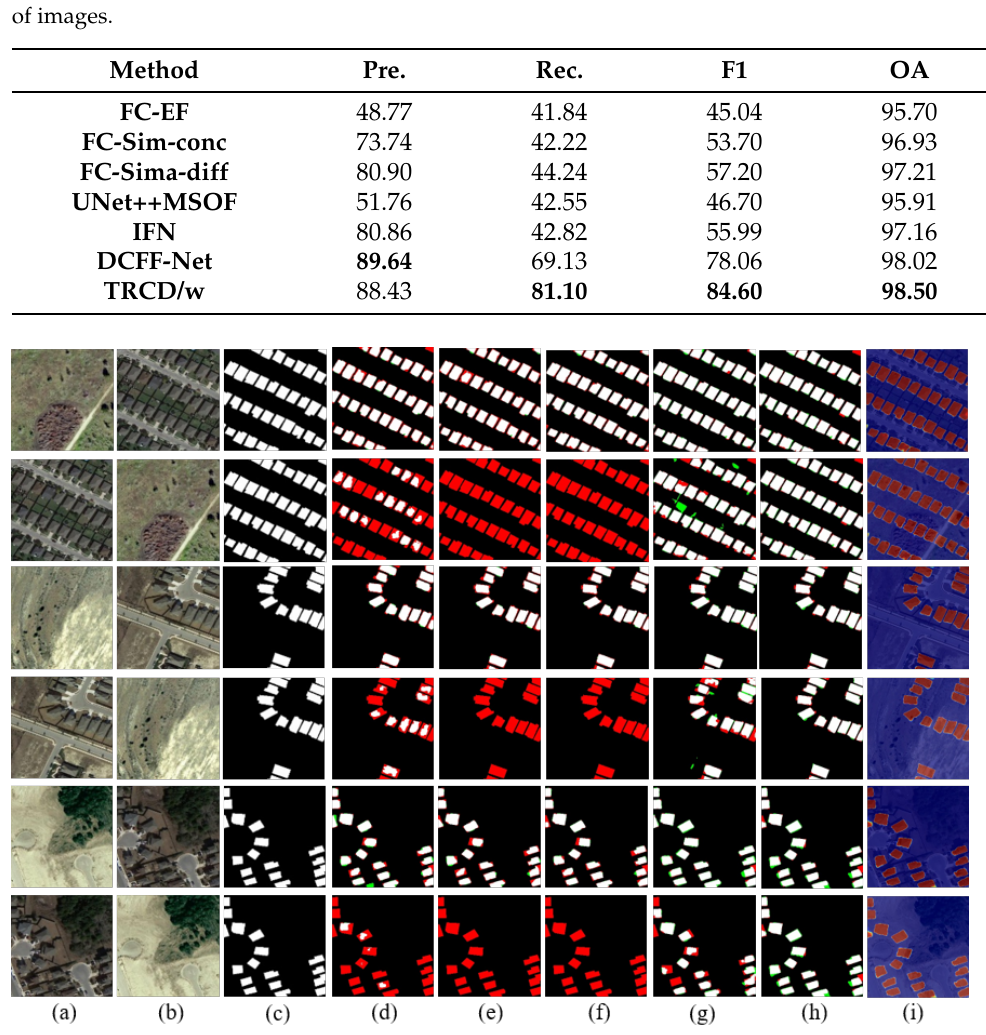
Figure 11. Qualitative comparison including the detected changes from image t1 to image t2 and changes from image t2 to image t1 on the LEVIR-CD dataset. The odd and even rows represent the detection results from image t1 to image t2 and results from image t2 to t1, respectively. TP is shown in white, TN is shown in black, FP is shown in green, and FN is shown in red: ( a ) prechange, ( b ) postchange, ( c ) ground truth, ( d ) FC-siam-diff, ( e ) UNet++MSOF, ( f ) IFN, ( g ) DCFF-Net, ( h ) our prosed model, and ( i ) attention